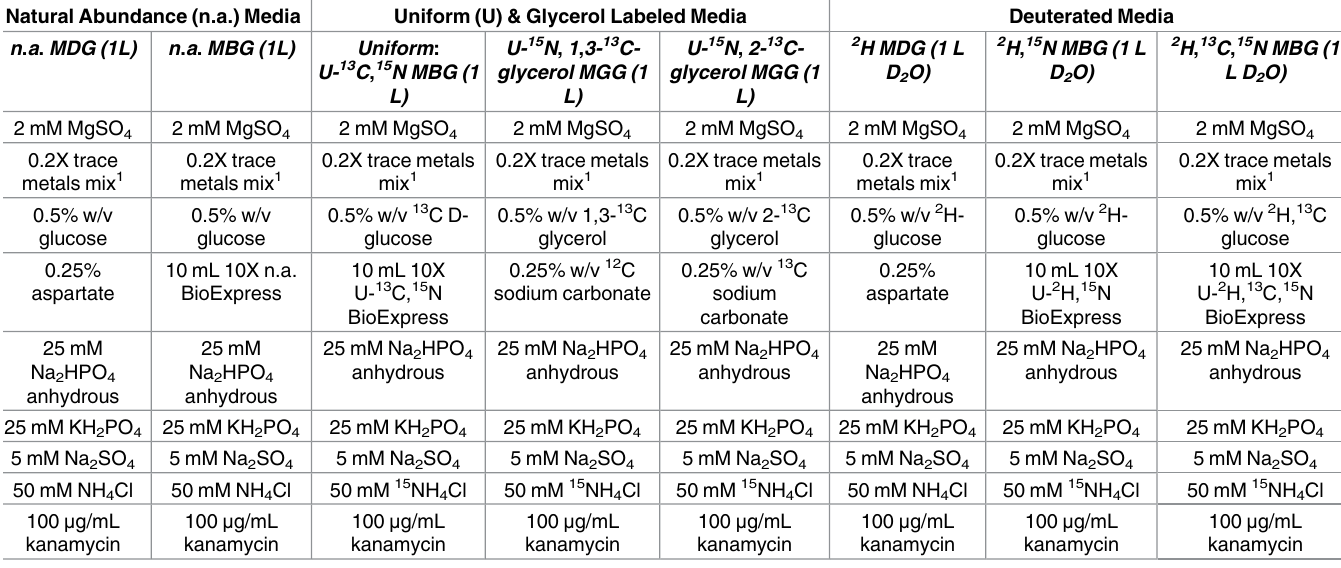
Table 1. Components of media used for isotopically labeled growths of sTF. Natural Abundance (n.a.)